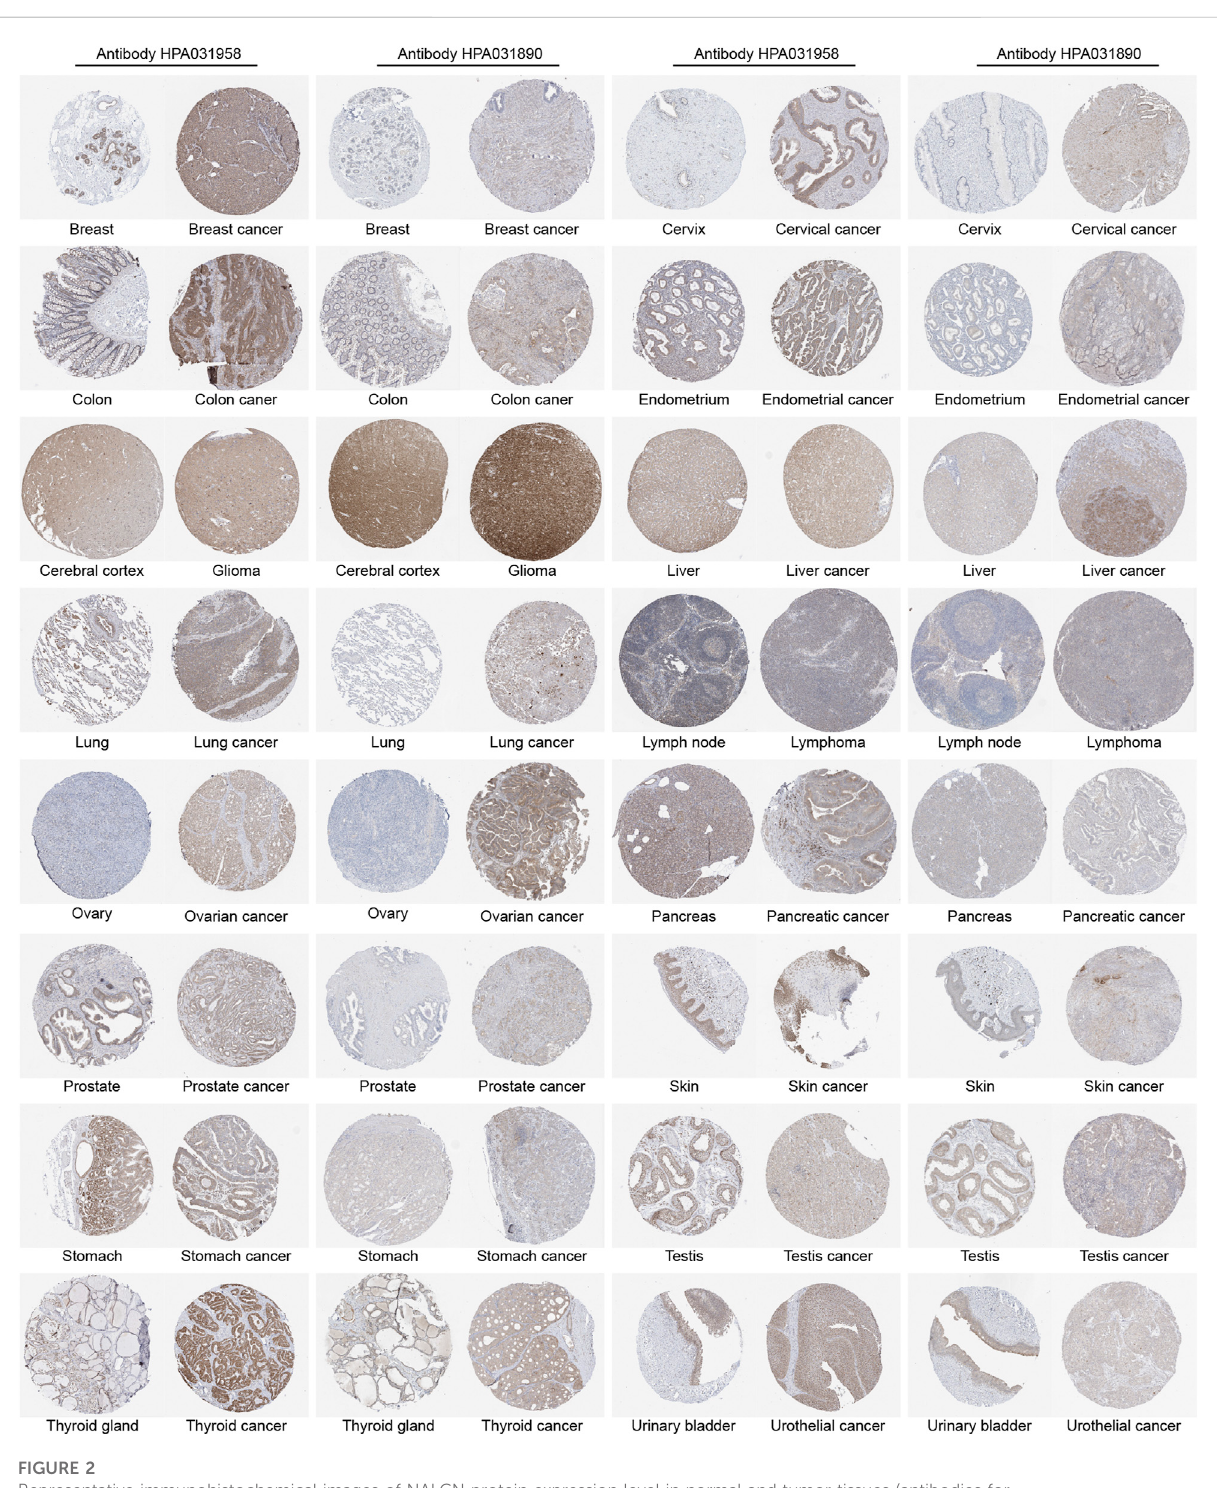
a protective factor for ACC and LGG (Figure 3A). KM survival analysis indicated that higher NALCN expression was associated with a poorer OS in BLCA, COAD, HNSC, and KIRP, while with better OS in ACC and LGG (Figure 3B). For PFI, increased